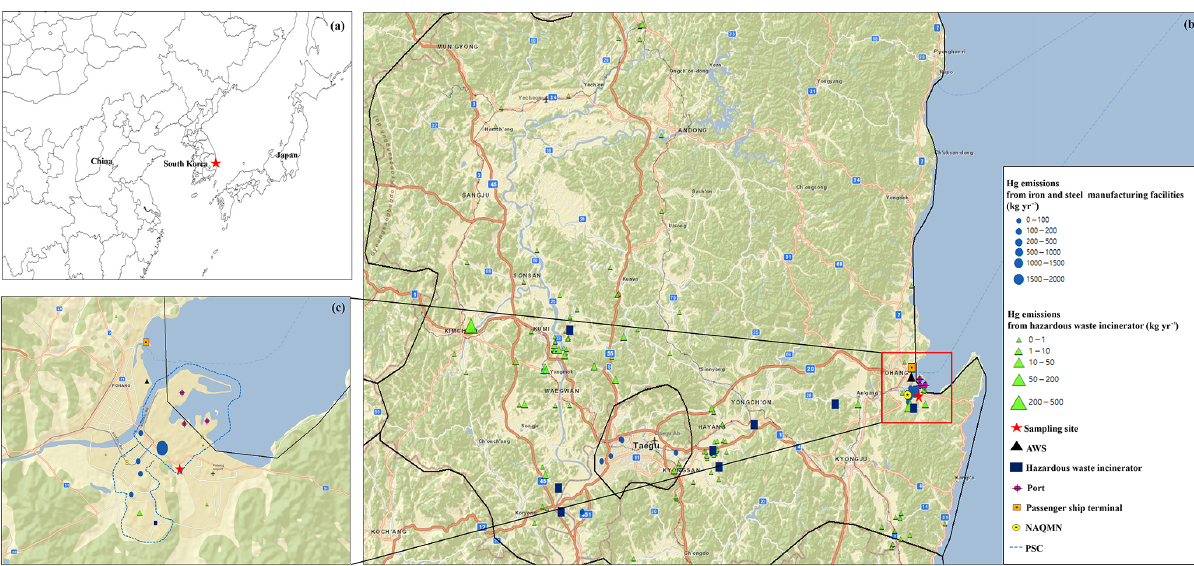
Figure 1. The location of sampling site in this study ( a , South Korea; b , Gyeongsangbuk-do; and c , Pohang). AWS, NAQMN and PSC represent automatic weather station, National Air Quality Monitoring Network and Pohang steel complex,